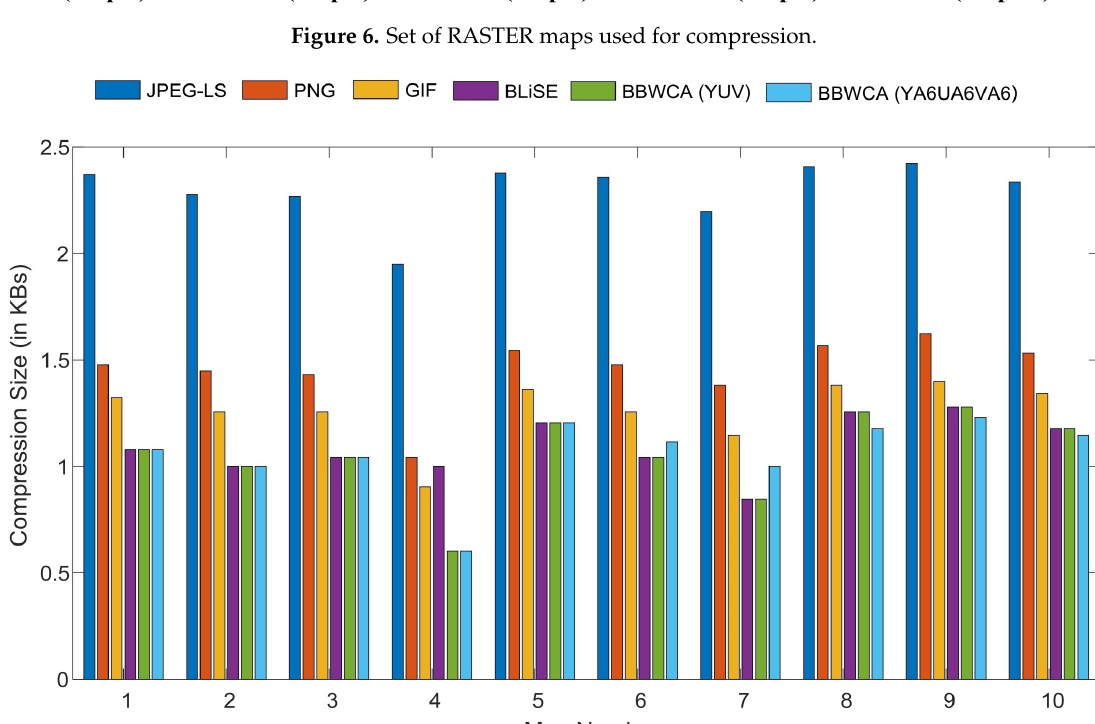
Figure 7. Comparative analysis of RASTER maps of different compression sizes. Original image size is 843 KB. Values on y-axis are displayed on the logarithmic scale for a better visual